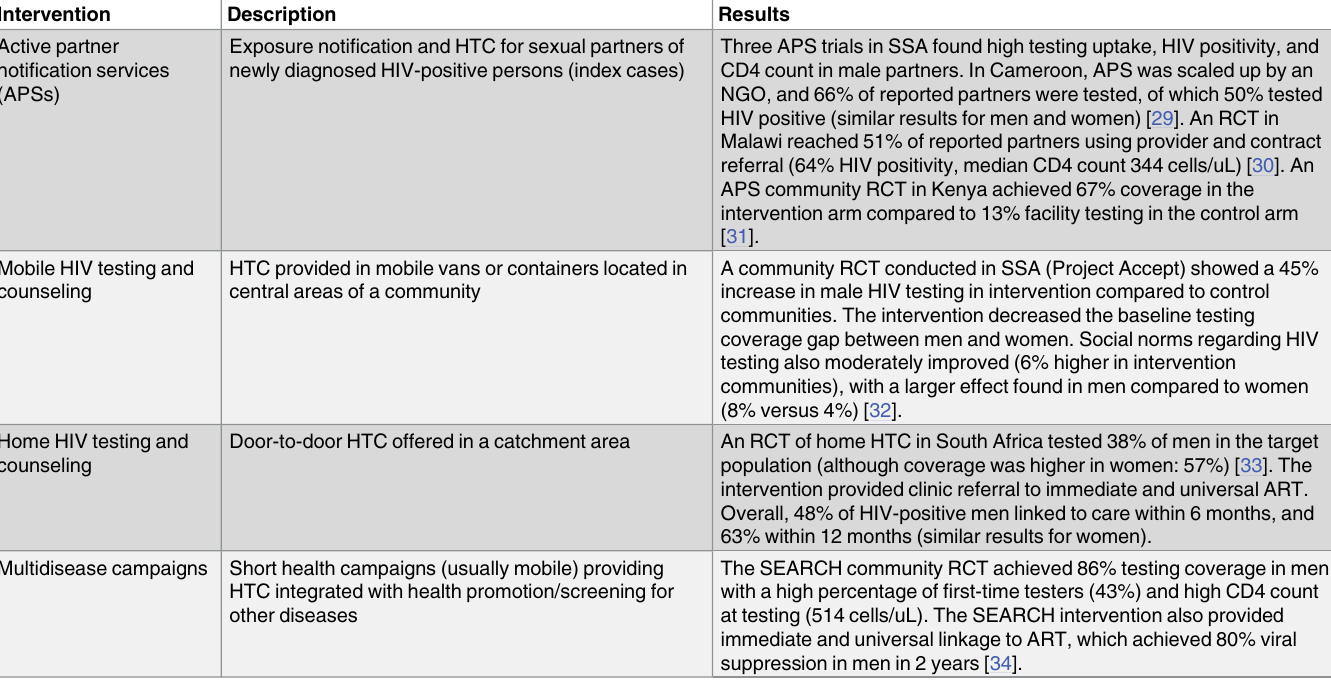
Table 1. Community-based HIV HTC interventions to increasemale testing and engagement in